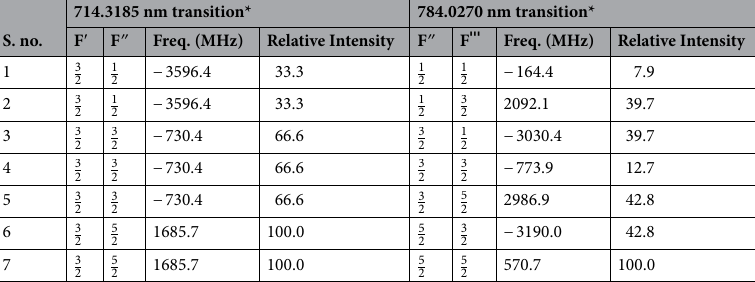
Table 2. A table of hyperfine pathways of 223 Ra isotope. *F ʹ , F ʺ and F ˈˈˈ are the hyperfine levels of the first, second and third excitation